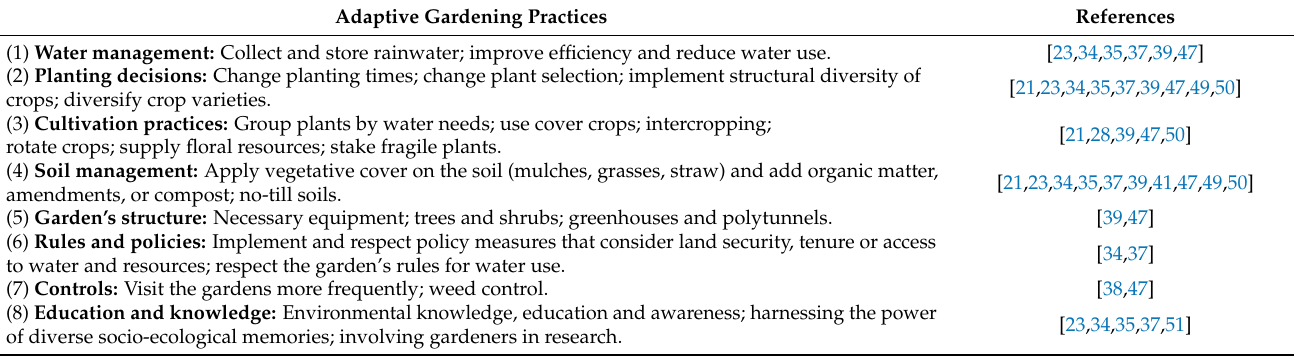
Table 3. Adaptive urban gardening practices in responses to climate